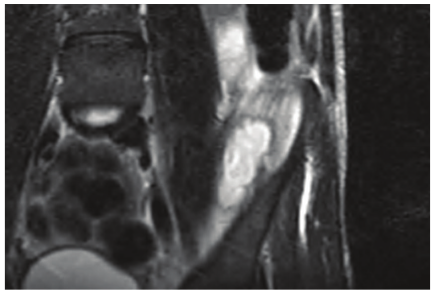
Figure 3: MRI image of iliacus